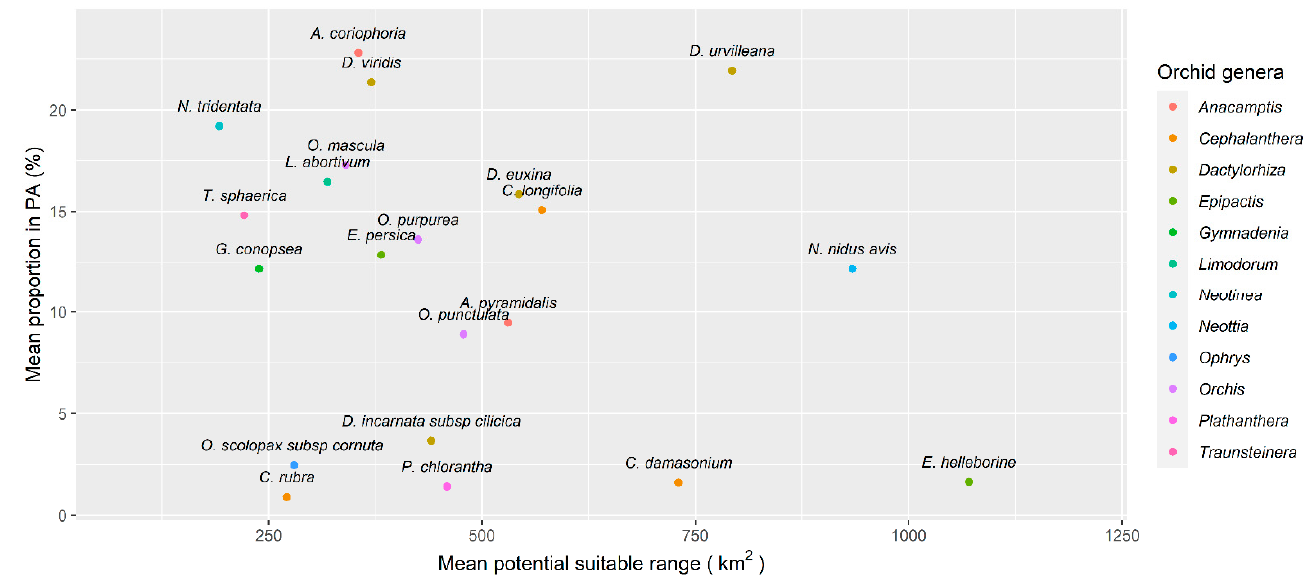
Figure 2. Scatterplot showing species potential climatic suitability range (km 2 ) against the mean proportion of species range within a PA represented as a percentage. Colors represent genera according to the World Checklist of Vascular Plants.